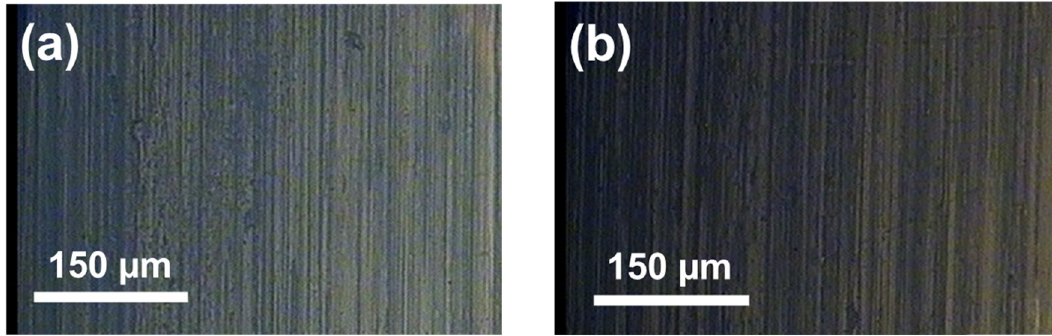
Figure 2: Optical microscopy of Arboblend V2 Nature samples made at ( a ) 160°C and ( b )